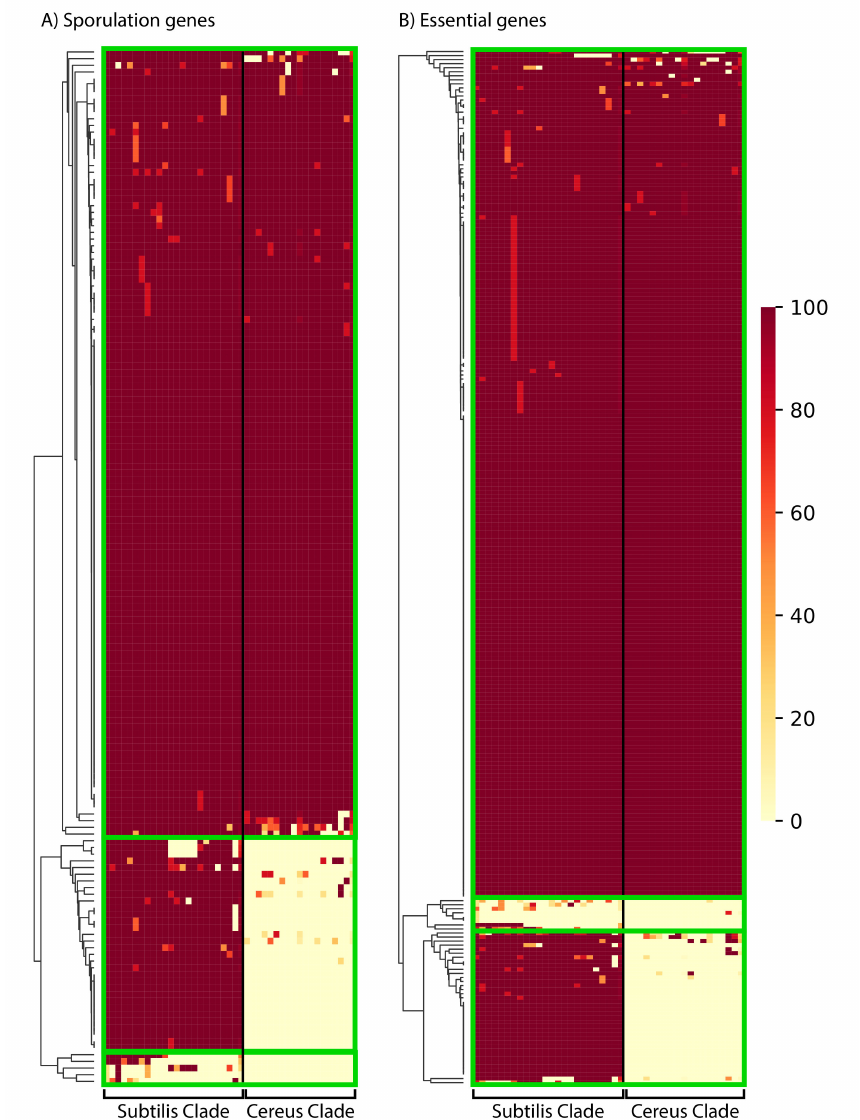
Figure 6. The phylogenetic distribution pattern of: ( A ) 155 B. subtilis proteins important for sporula- tion; ( B ) 256 proteins that are essential in B. subtilis . Presence of a close homolog in a given species of the Subtilis and Cereus Clades was determined based on 50% amino acid identity over 50% of the protein’s length. The clustering of proteins (based on their distribution) was performed with the average Euclidean distance, within the seaborn.clustermap python package. A more detailed view of the cluster-heatmaps (including the individual gene names and species) is available in Supplementary Figures S4 and S5. Each row corresponds to a gene and each column corresponds to a certain species. The color in the heatmap corresponds to the % presence (how many strains of the species) of that gene in that certain